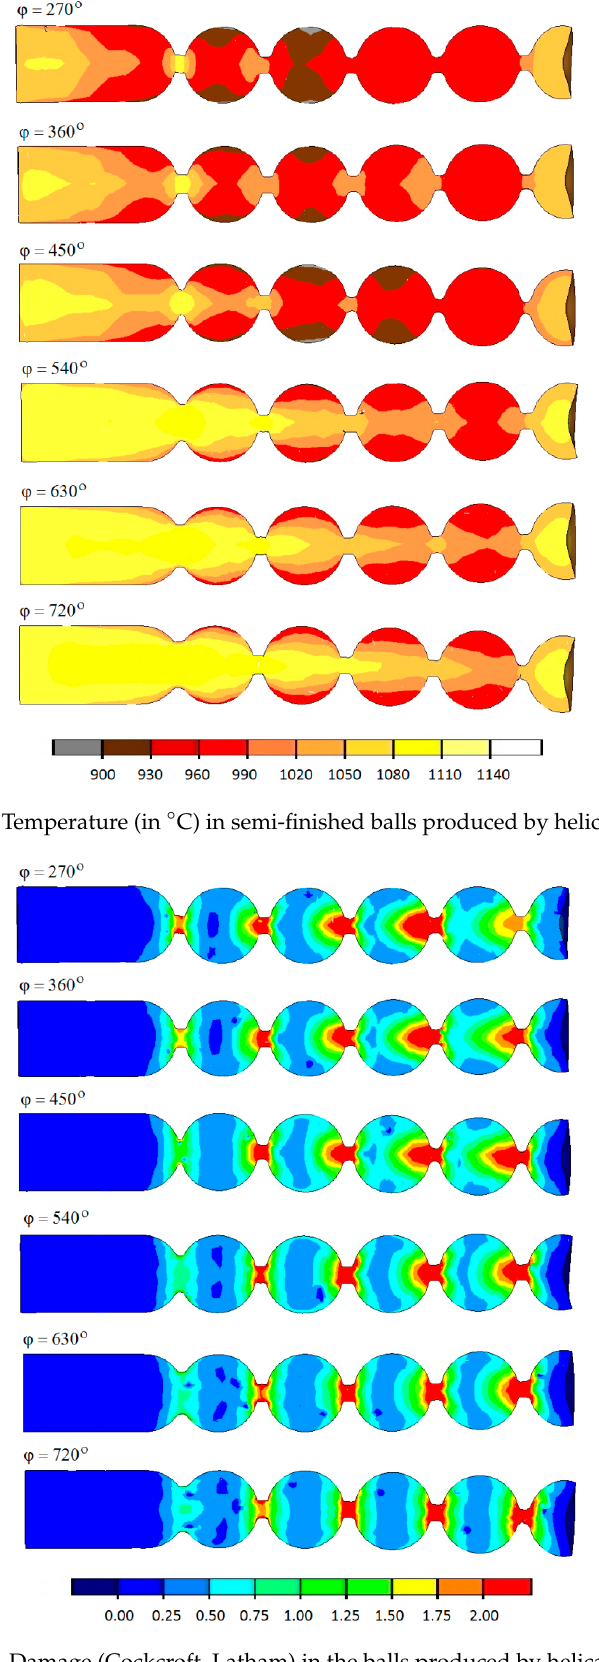
Figure 12. Damage (Cockcroft–Latham) in the balls produced by helical rolling.